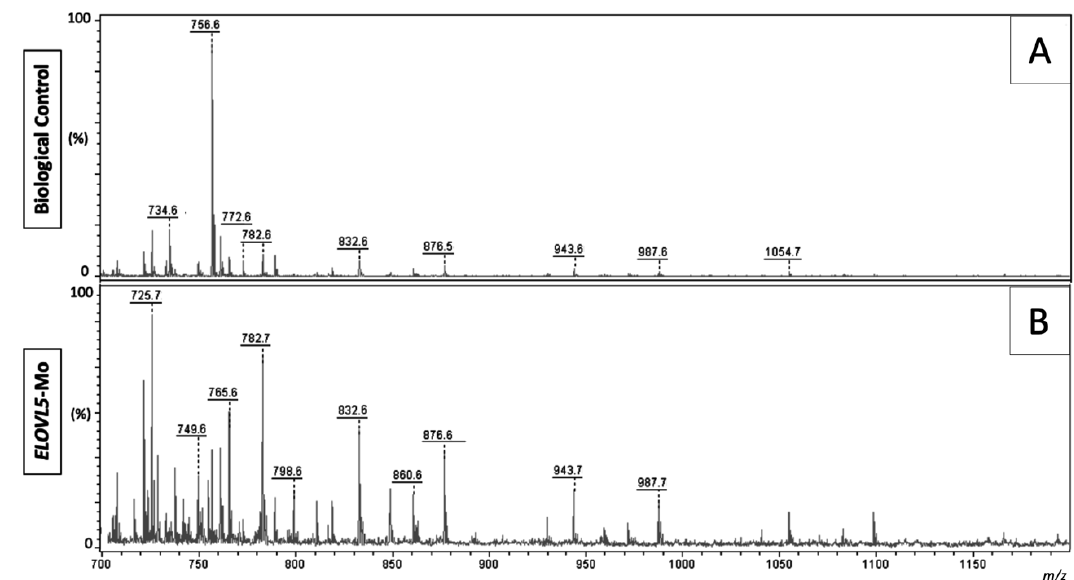
Figure 4. Representative matrix-assisted laser desorption and ionization mass spectrometry (MALDI-MS) spectra in the positive ion mode of biological controls ( A ) and ELOVL5 -Mo–derived ( B ) in vitro-produced bovine embryos; the intensity presented is relative to the most intense ion peak, and each peak represents a lipid species. n = 15 per group.